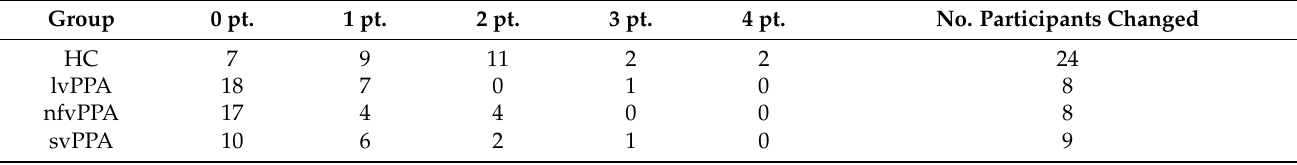
Table A2. The number of participants whose score increased by 1-4 points with the CU-uniqueref method. Group 0 pt.